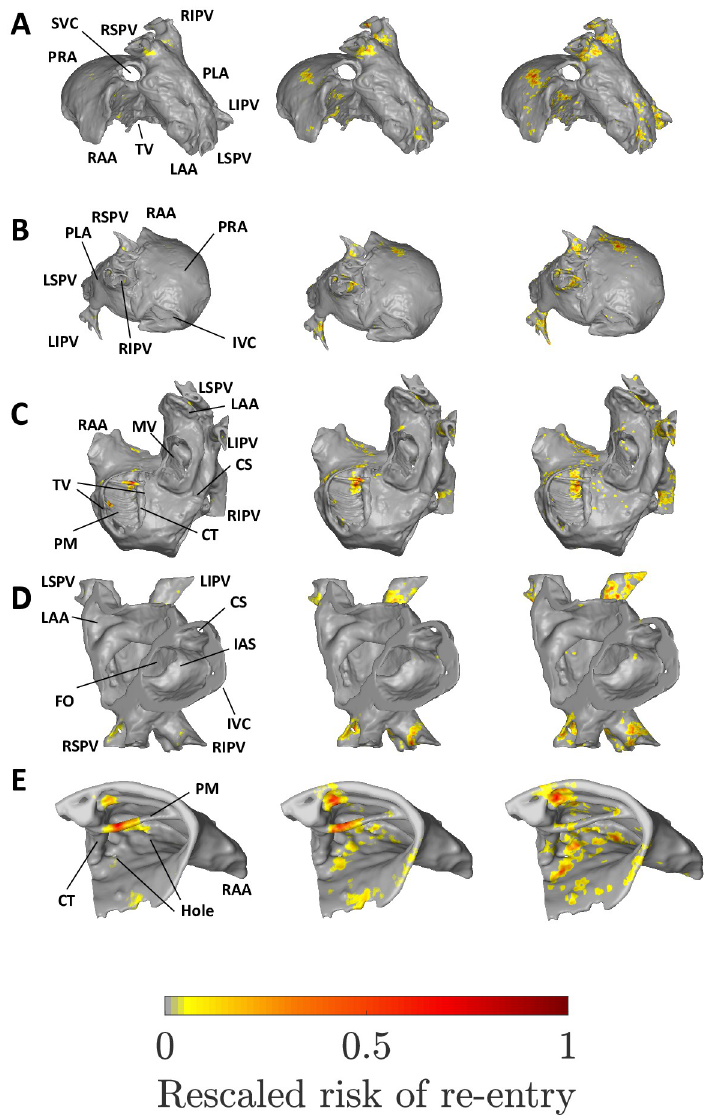
Fig 6. The micro-reentrant substrate for the human atria using the fibre-less null model at low (left column), medium (middle) and high global risk of micro-reentry (right). A: Superior view. B: Posterior view. C: Inferior view. D: Cut-through. E: Superior right atrial zoom. See Fig 5 for